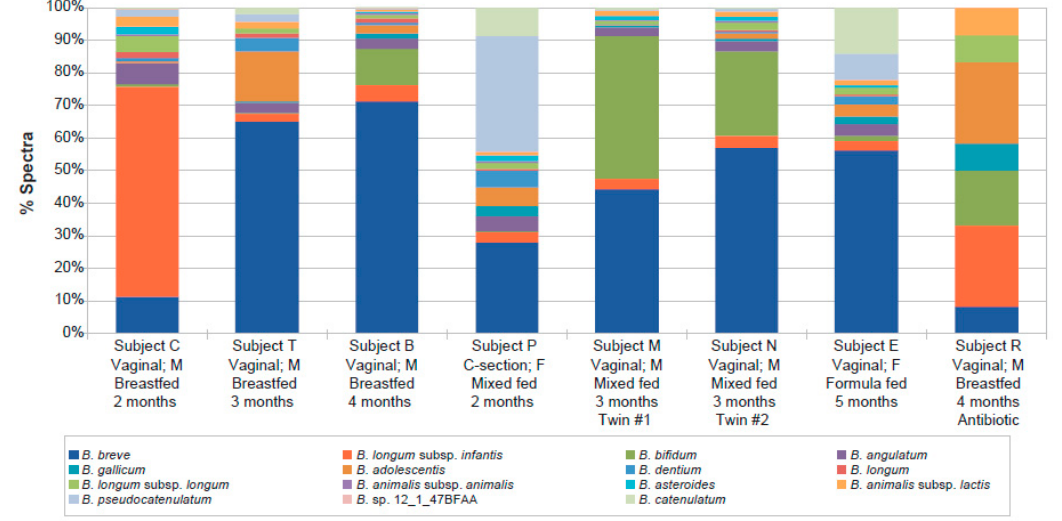
Figure 2. Relative Bifidobacterium species abundance per infant as detected by metaproteomics. Strain-level assignments were combined at the species level by summing spectral counts identified in individual strains.